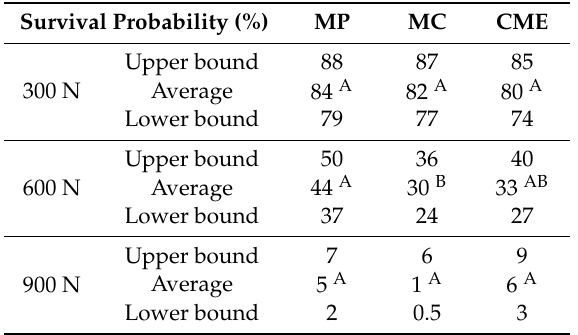
Figure 6. Weibull plot: survival probability versus load (N) reported on sample failure during the fatigue test. Table 2. Crowns survival in fatigue at di ff erent load